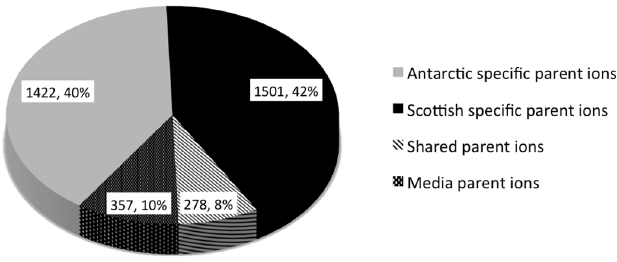
Figure 4. Relative proportions of location-specific parent ions identified by molecular network analysis (Figure 2).